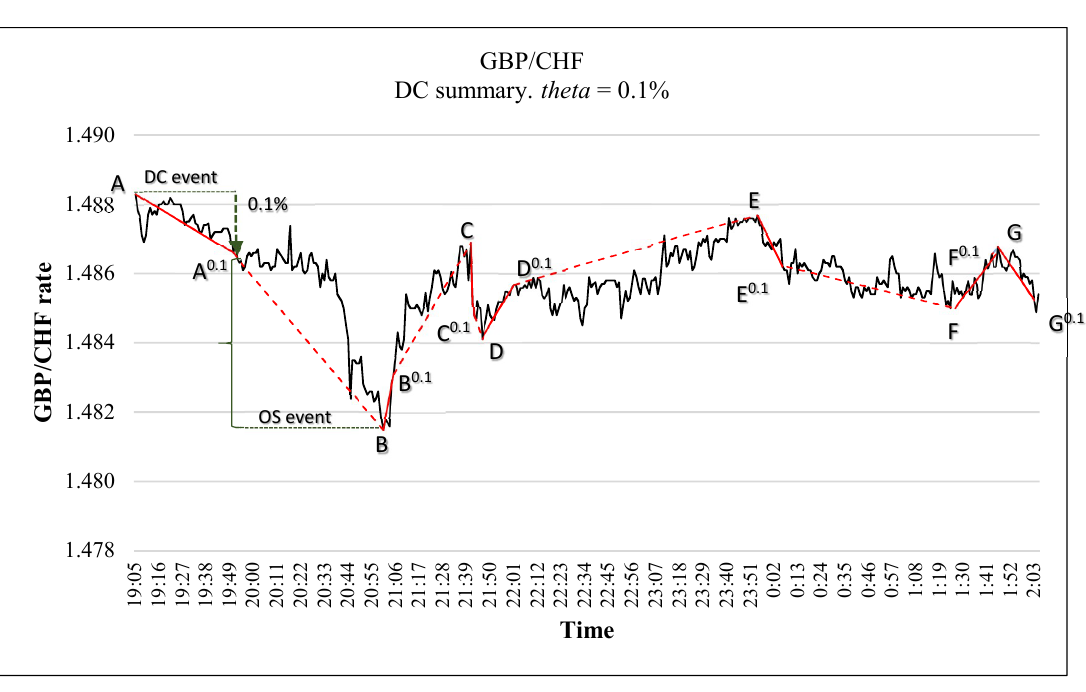
Figure 2. An example of a DC-based summary of the price series shown in Figure 1. Threshold theta = 0.1%. The black line indicates GBP/CHF mid-prices sampled minute by minute. Solid red lines represent DC events. Dashed red lines represent OS events. Each of the points A, B, C, D, E, F, and G is an extreme point. Each of the points A 0.1 , B 0.1 , C 0.1 , D 0.1 , E 0.1 , F 0.1 , and G 0.1 is a DC confirmation point (DCC point).